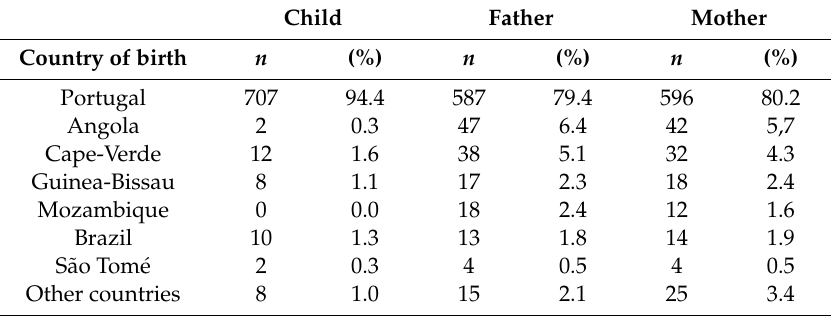
Table 1. Country of birth of the children and their parents.